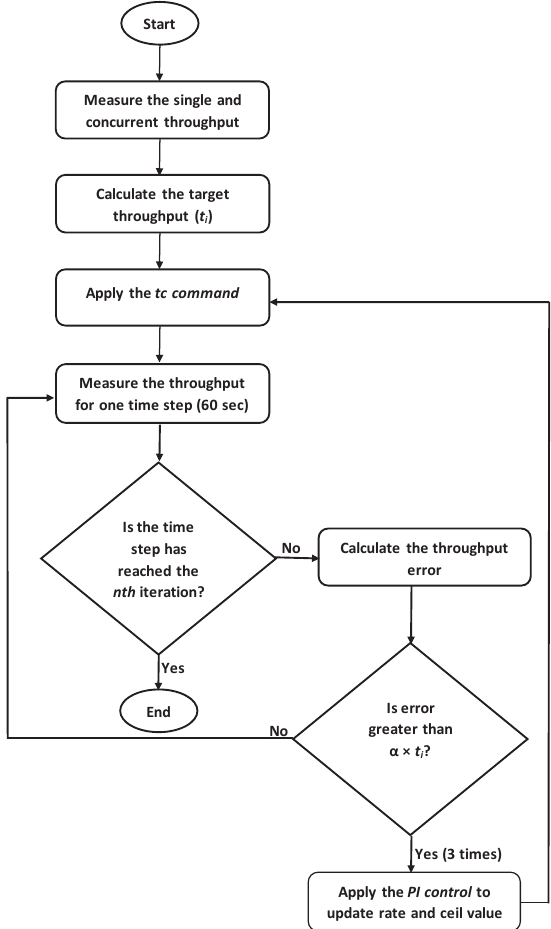
Figure 3. Flow of throughput request satisfaction method.